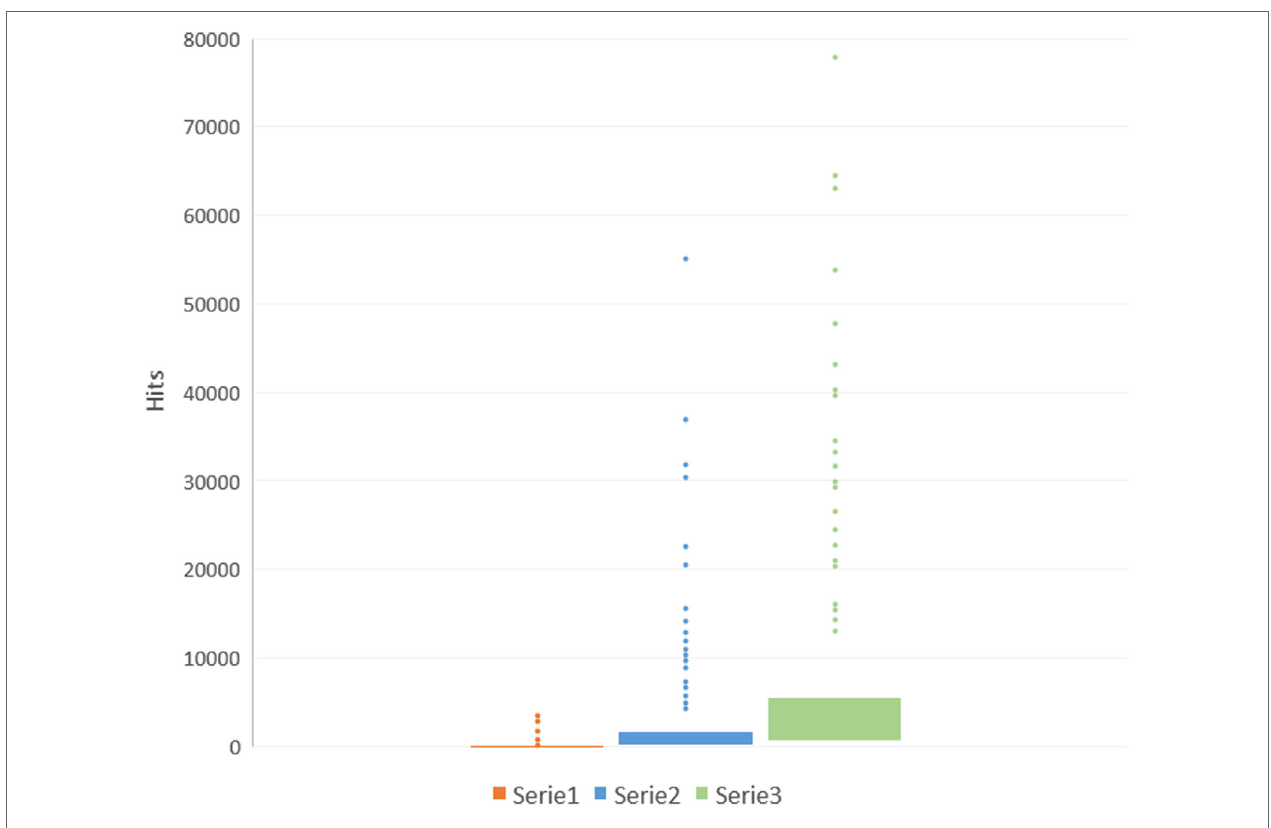
FigUre 3 | Author-level metrics box-and-whisker